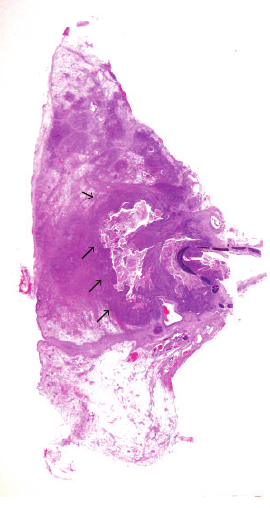
Figure 4: LS clearly visualizes the relationship between lung cancer (indicated by the arrows) and the surrounding obstructive pneumonia.